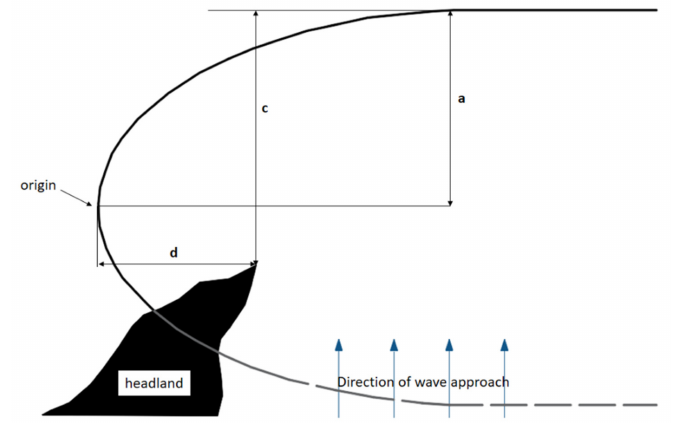
Figure 4. Definition sketch of parameters for the modified hyperbolic-tangent equation. It is worth noting that the hyperbolic-tangent model could be applied not only to bay in static equilibrium conditions, but also to fit a bay under non-equilibrium conditions [3].